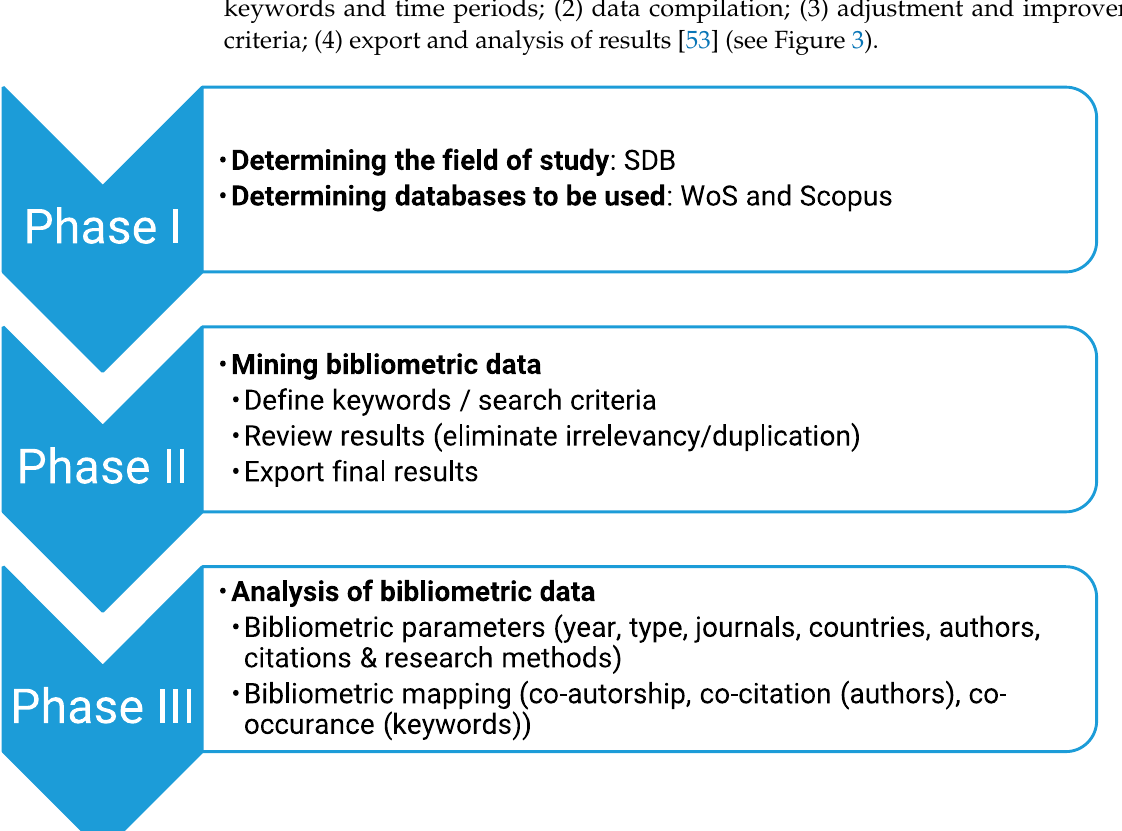
Figure 3. Methodological scheme of the process carried out in this study.